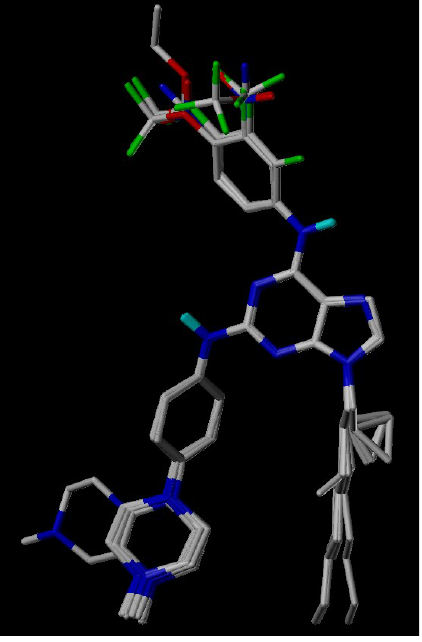
Figure 4. Superimposed structures of all compounds used in CoMFA